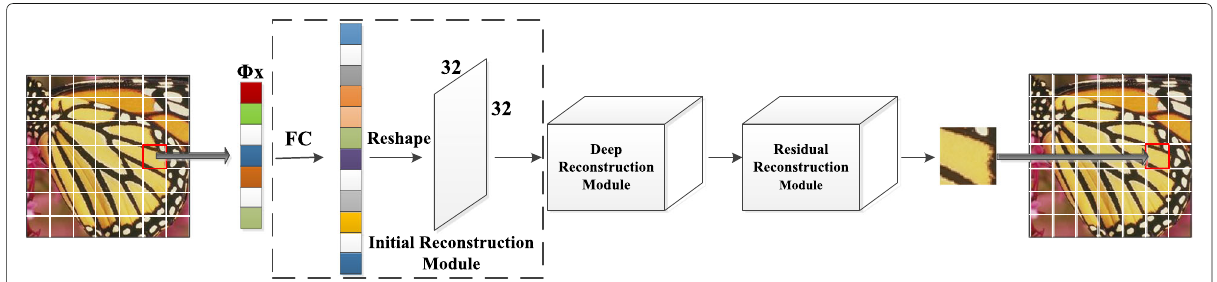
Fig. 1 The framework of CSRNet